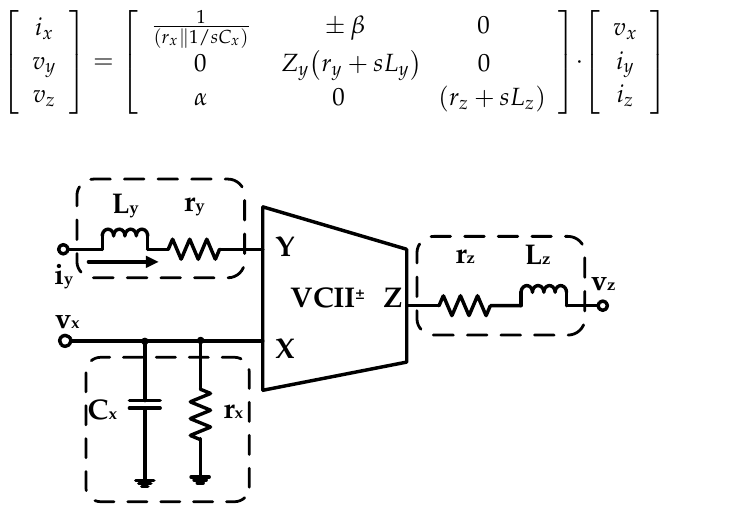
Figure 1. Second-generation voltage conveyor (VCII) equivalent representation. Dashed boxes highlight the parasitic components at each terminal.